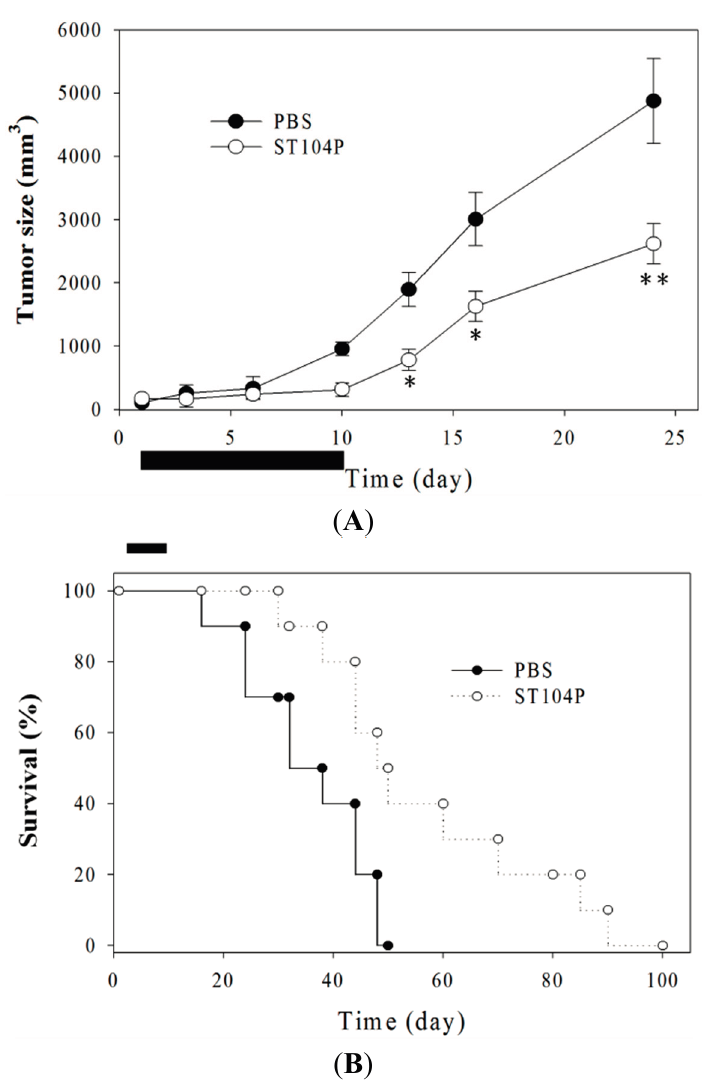
Figure 3. Injection of ST104P suppressed tumor growth and prolonged the survival of Lewis lung carcinoma in mice. ( A ) The subcutaneous dorsa of mice were implanted with Lewis lung carcinomas. The tumor sizes in mice during treatment with ST104P or control were recorded. Treatment was performed by intratumor injection of ST104P (100 µg in 0.1 mL PBS) daily from day 0 to day 10 as indicated by the horizontal bar. Data were mean ± SEM for ten mice. Asterisks indicate statistical significance versus control. * p ˂ 0.05 and ** p ˂ 0.01; and ( B ) The overall survival rates of PBS- or ST104P-treated mice ( n = 10). Kaplan-Meier survival analysis indicated the ST104P treatment significantly enhanced the survival rates of tumor-bearing mice ( p < 0.001). This experiment was repeated with comparable